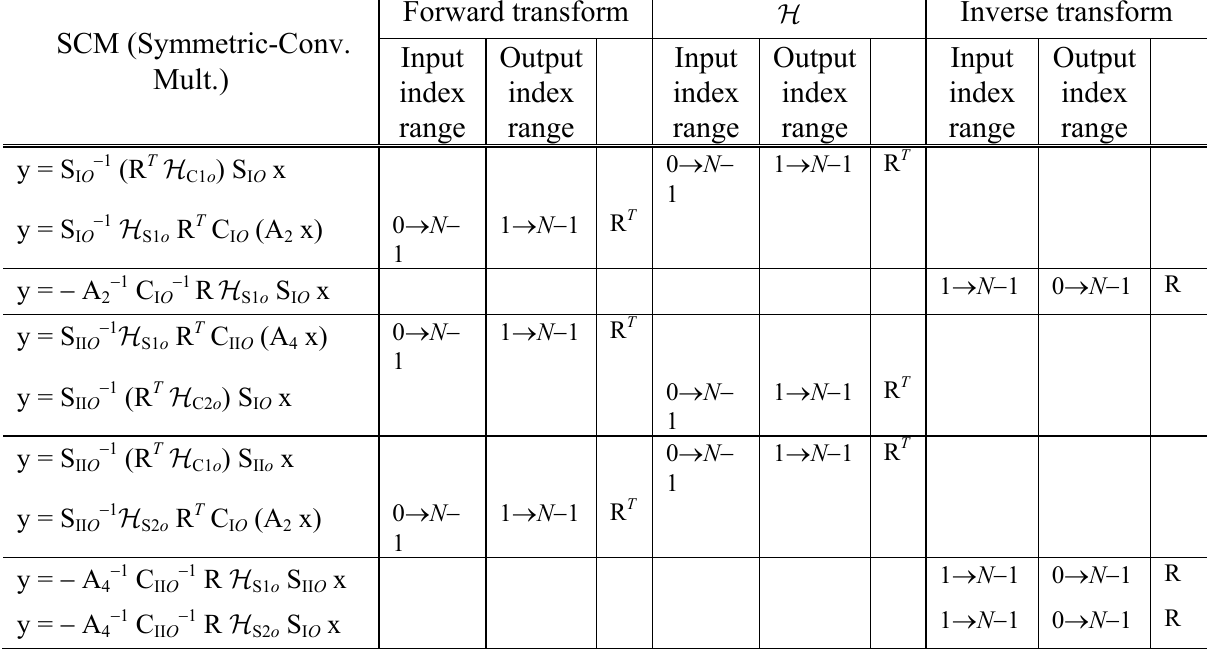
Table 2. Link between the index range-based maneuvers described by Martucci [2] and the introduction of the J, K, Q and R matrices, M = 2 N  1. SCM